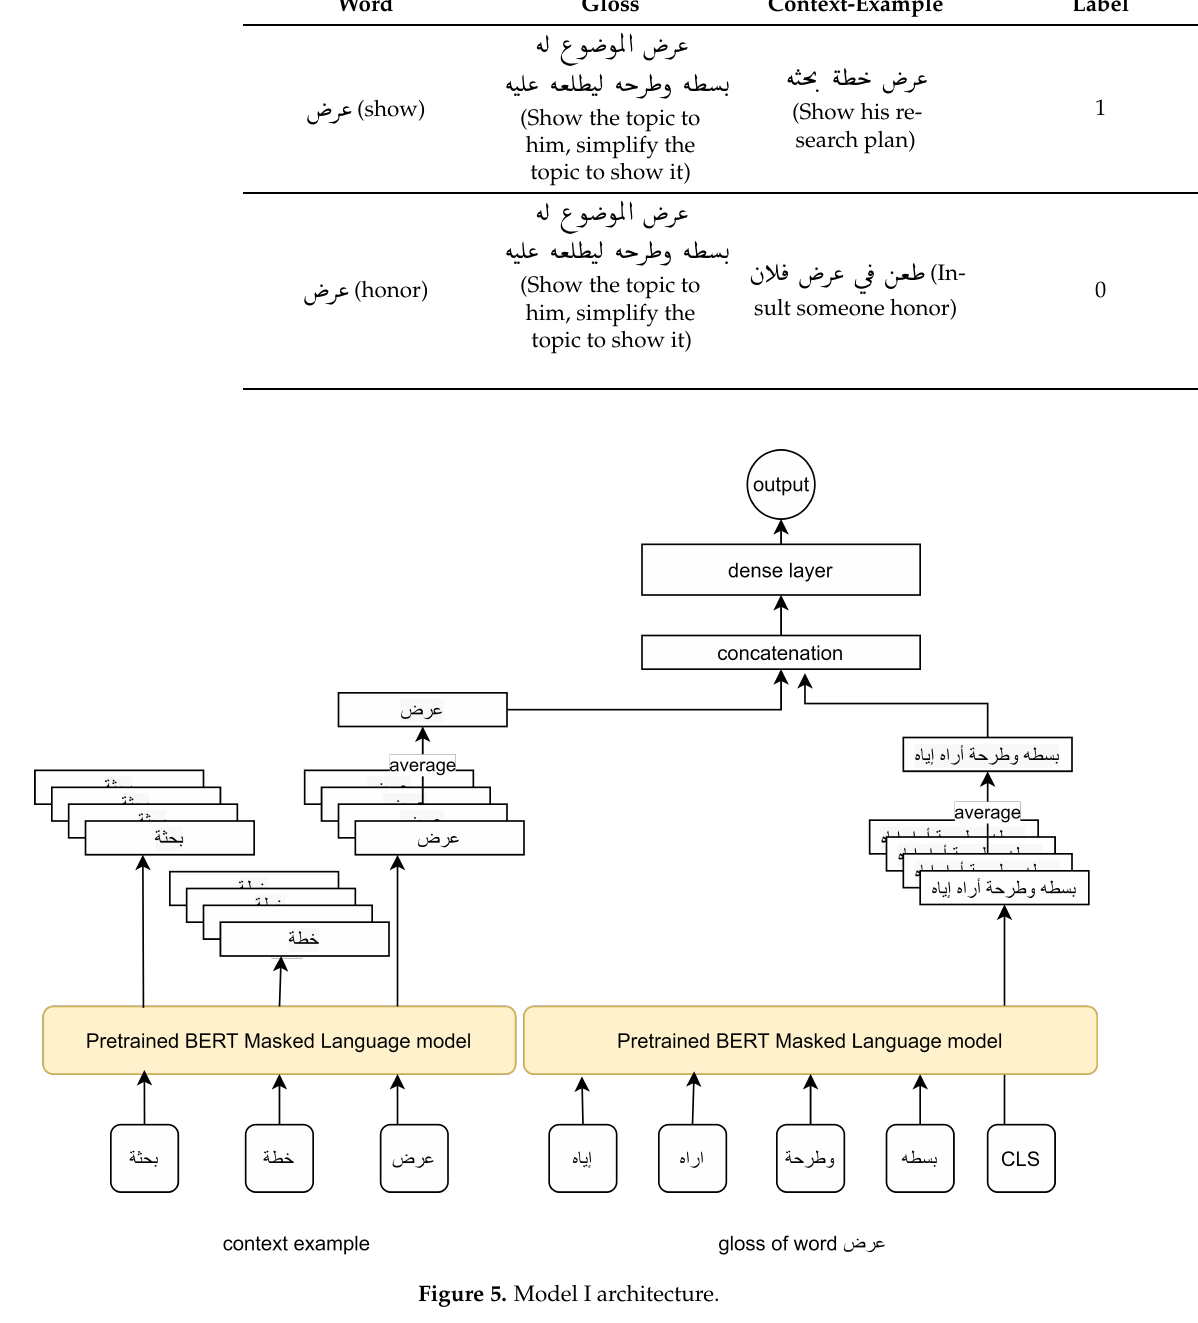
Figure 5. Model I